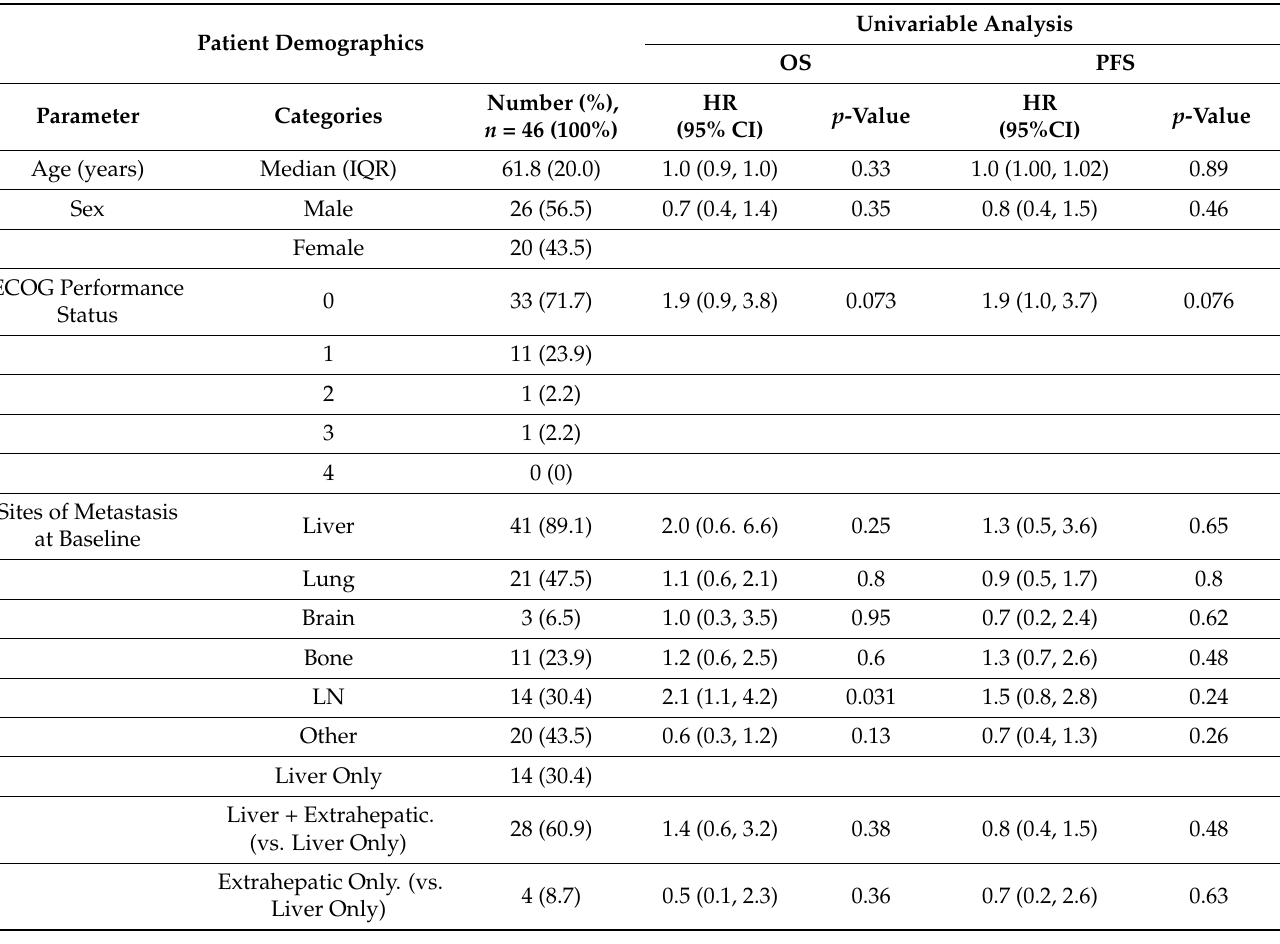
Table 1. Patient Characteristics.